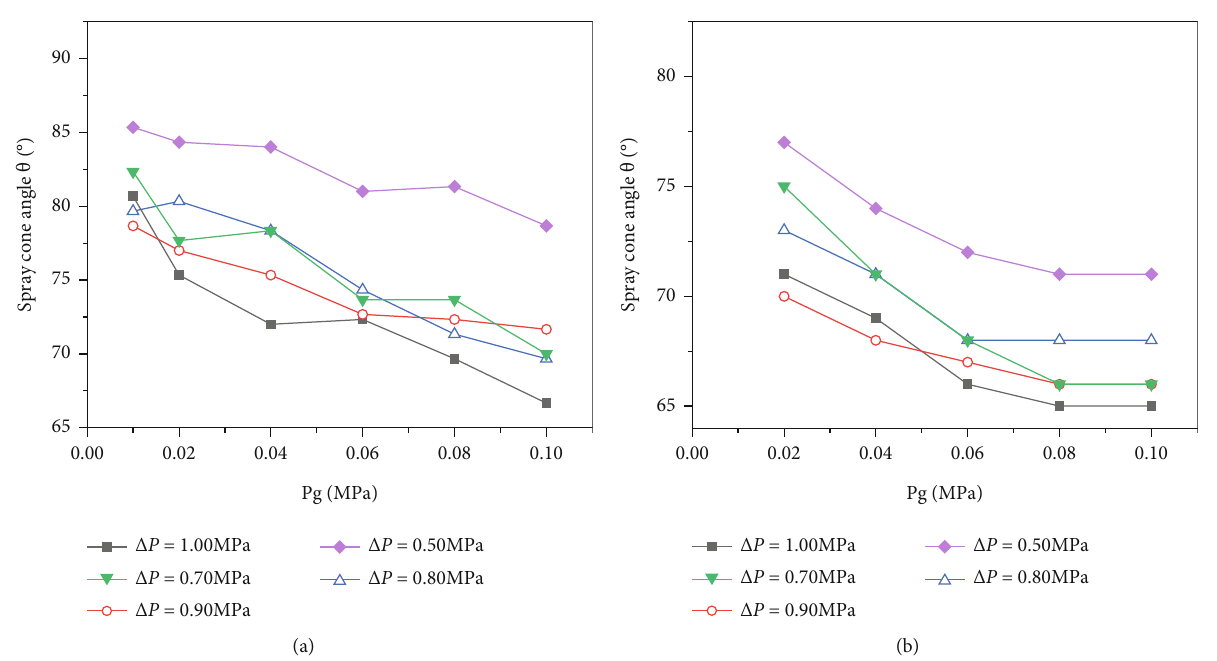
Figure 6: Spray cone angle with ambient gas pressure: (a) 1 # atomizer; (b) 2 # atomizer.